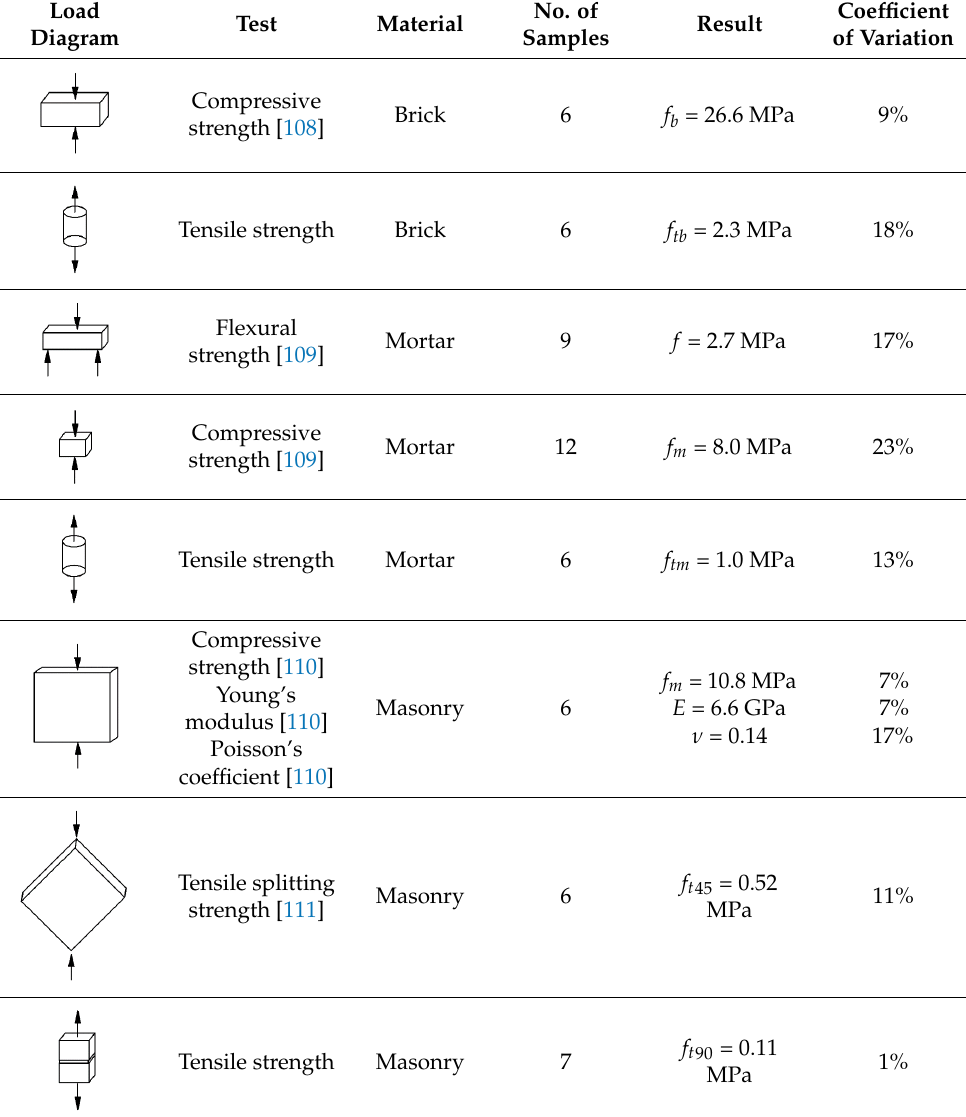
Table 2. Properties of used materials.